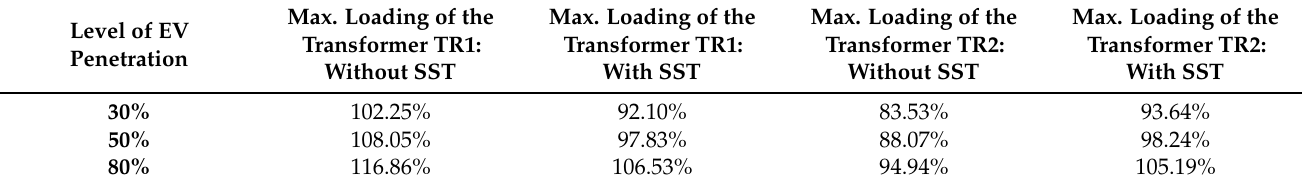
Table 1. EV penetration and the reduction in transformer loading with SST for each case.